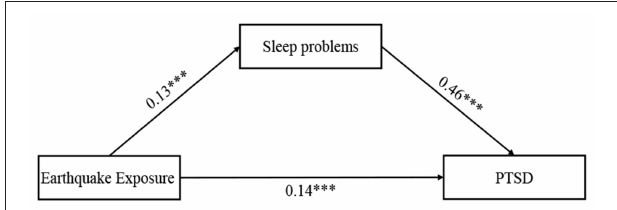
FIGURE 1 | The mediating effect in the association between earthquake exposure and PTSD